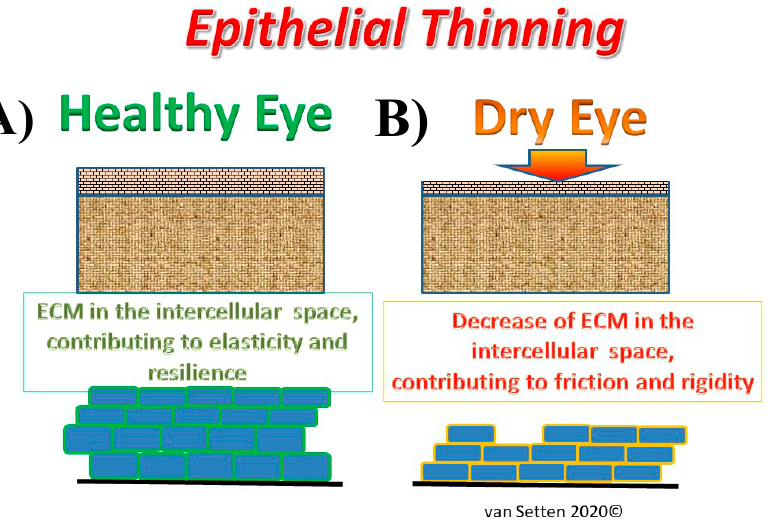
Figure 1. Illustration of the effects of epithelial thinning changing the extra cellular matrix in the intercellular space from a physiological condition ( A ), where the extra cellular matrix (ECM) contributes to elasticity and resilience of the tissue to an impaired condition in DED ( B ) with thinning of the ECM, leading to a compressed intercellular space, contributing to enhanced friction and rigidity .